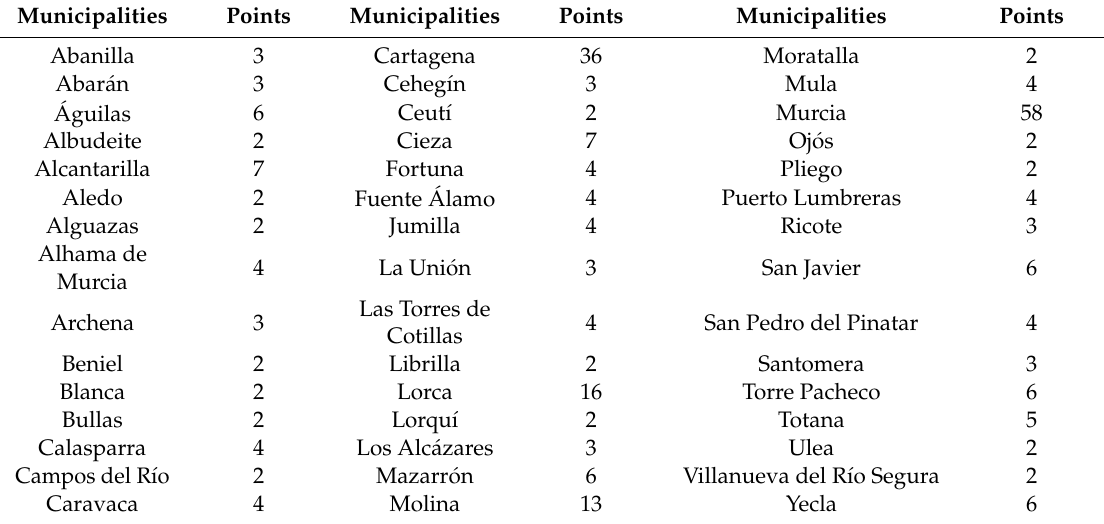
Table 1. Number of sampling points per